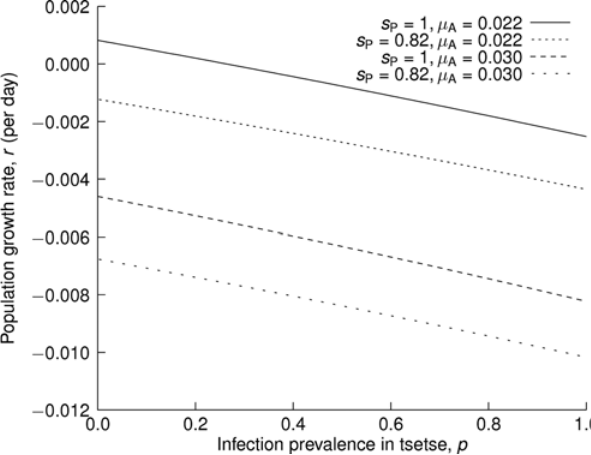
Figure 5. The relationship between population growth rate and prevalence of immunogenic trypanosome strain for different pupal survival ( s P ) and adult mortality rates ( m A ). In all cases, the curves are well approximated by lines with slope between about 2 0.0031 and 2 0.0036 per day, so that a 10% increase in prevalence corresponds to a 0.031–0.036 per day decrease in population growth rate. The units of m A are per day.